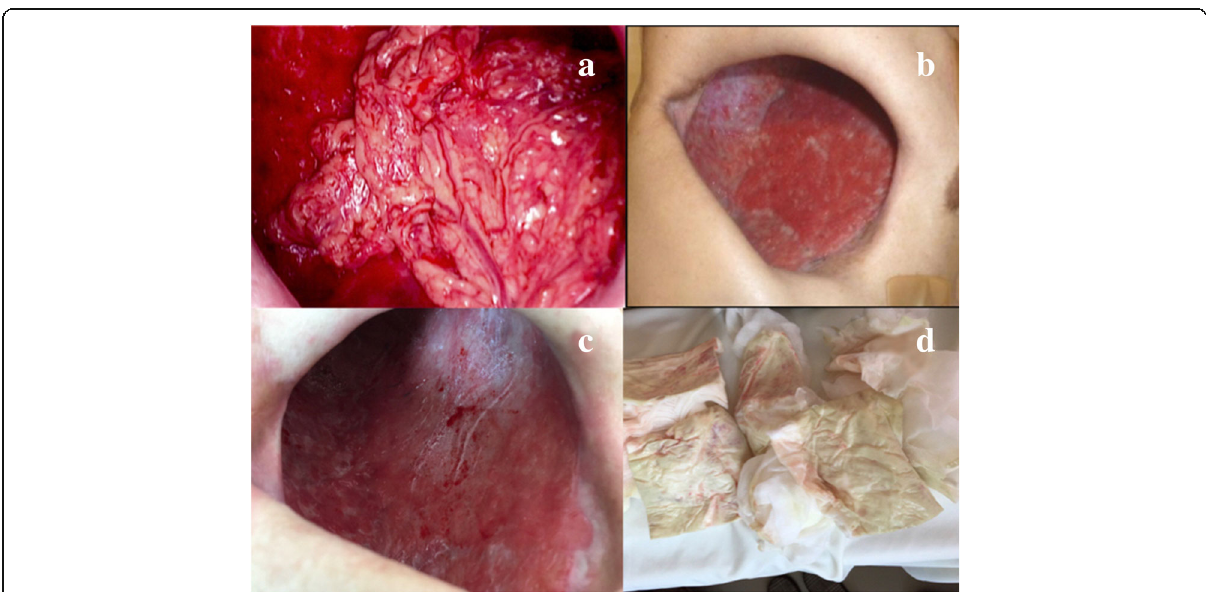
Fig. 2 Bronchopleural fistula closure promoted the growth of healthy thick granulation tissue covering the whole cavity, thereby reducing the